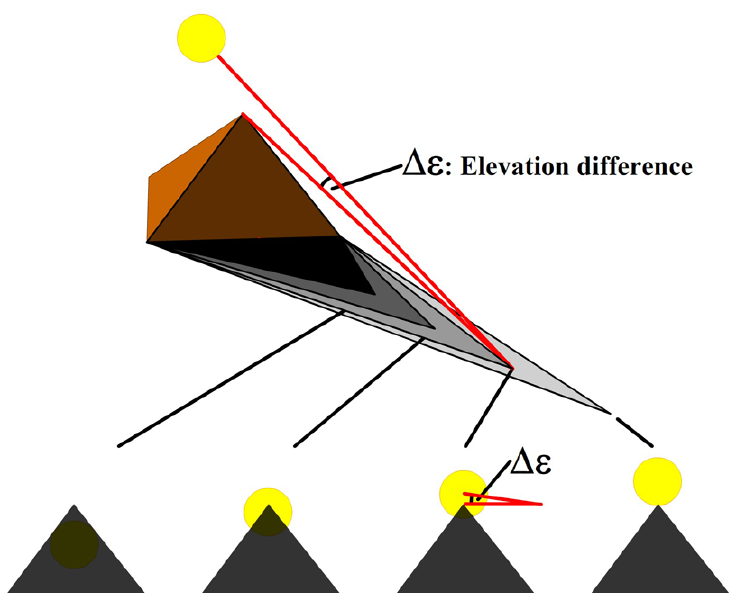
Figure 6. Schematic of the theoretical shadow profile calculation process. We compute the intensity at any given point using the solar elevation difference ∆ (cid:101) to superimpose the simplified triangular projector over the calculated solar disk. Then, we integrate the intensity within the fraction of the solar disk visible from any given point across the shadow